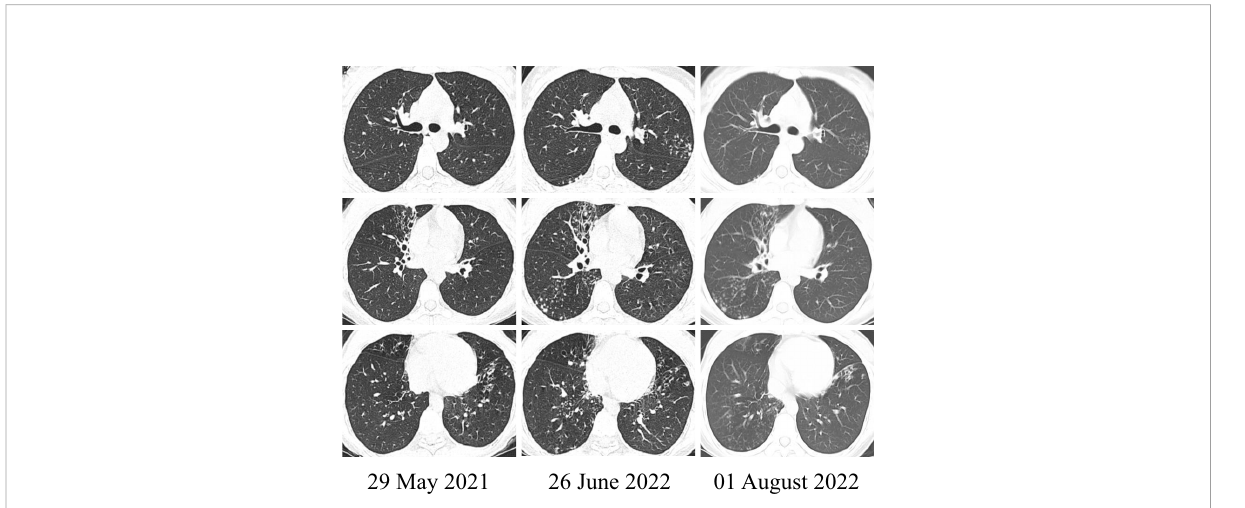
FIGURE 3 The representative image: changing in the patient ’ s chest CT. The CT on June 26, 2022, compared with May 29, 2021, showed more serious pneumonia with bronchiectasis in the RML and LLL. However, after the identi fi cation of Nocardia species and systemic treatment, the imaging on August 1, 2022, showed